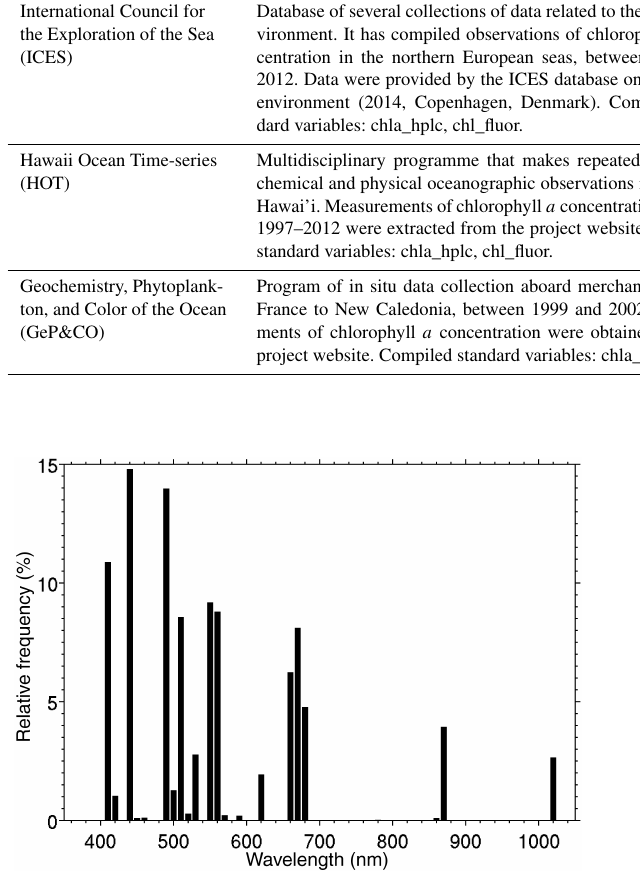
Figure 1. Relative spectral frequency of remote-sensing reflectance in the final table, using 10nm wide class intervals, defined as the ratio of the number of observations at a particular waveband to the total number of observations at all wavebands, multiplied by 100 to report results in percentage. Data at a total of 134 unique wave- lengths, between 405 and 1022.1nm, were compiled.